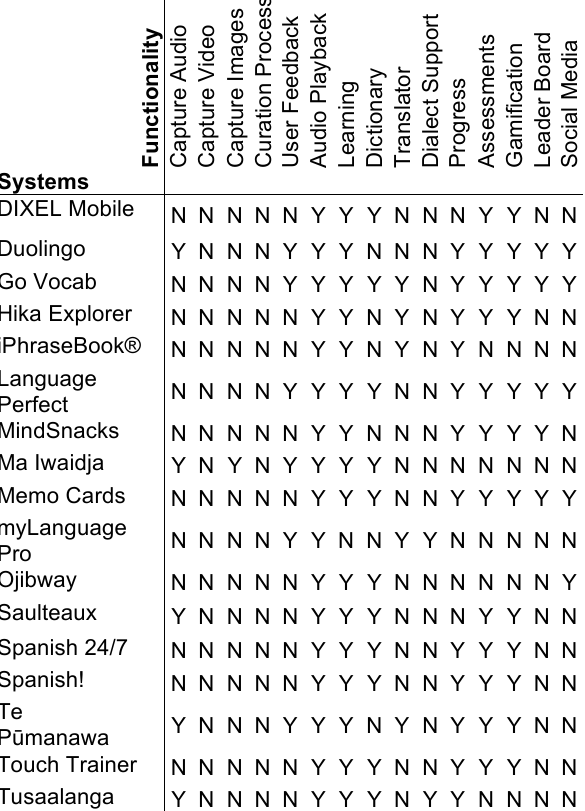
Table 1. Existing systems available for revitalising endangered